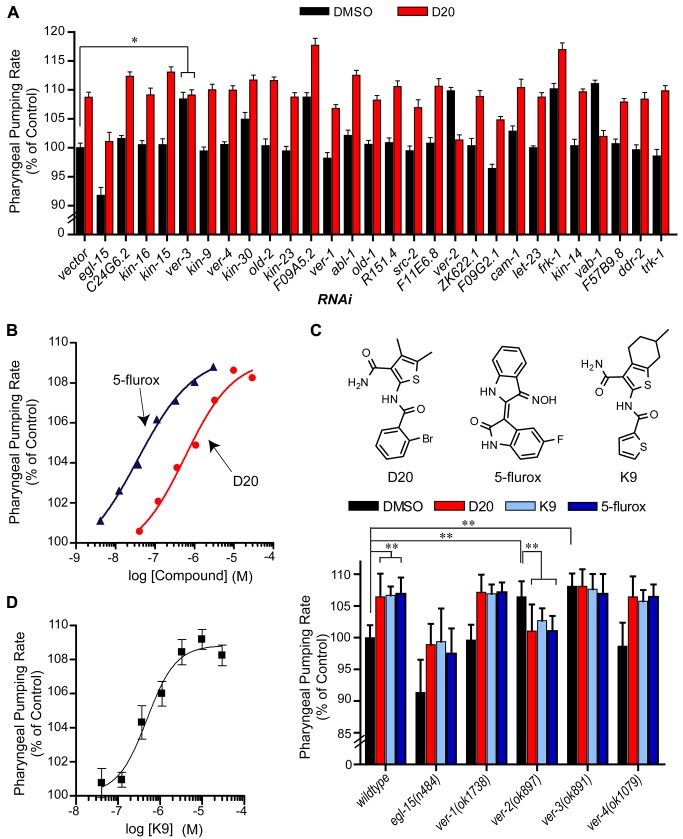
D20 antagonizes a VER-3–dependent pathway to induce pharyngeal pumping.(A) Animals were cultured on different RNAi clones in media supplemented with either 0.05% DMSO or 5 µM D20. Sequences are arranged based on their BLASTp similarity to the human FLT-3 receptor from most similar (left) to least similar (right). Error bars represent the s.e.m. **p<0.001, *p<0.01 (D20 versus DMSO): two-tailed t test. (B) Pharyngeal pumping rates of wild-type C. elegans treated with serial 3-fold dilutions of 5-flurox or D20. (C) The pharyngeal pumping rates of wild-type, egl-15(n484), ver-1(ok1738), ver-2(ok897), ver-3(ok891), and ver-4(ok1079) mutant animals cultured on 0.1% DMSO, 10 µM D20, 10 µM K9, or 2 µM 5-flurox. Error bars represent the standard deviation. Significance levels: **p<0.001 were determined by one-way ANOVA using Bonferroni's multiple comparison test. (D) C. elegans were treated with serial 3-fold dilutions of K9 and the pharyngeal pumping rate was quantified at each dose. Error bars represent the s.e.m. In (A–D) 10–20 animals were evaluated per condition.